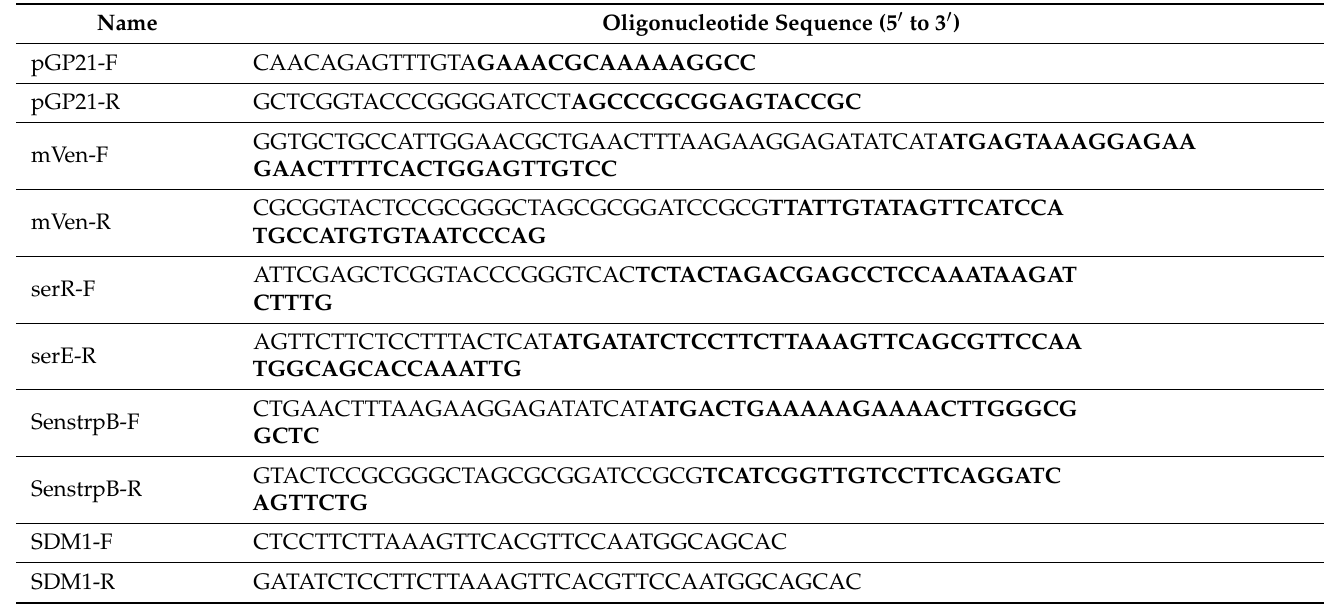
Table 2. Oligonucleotides used in this